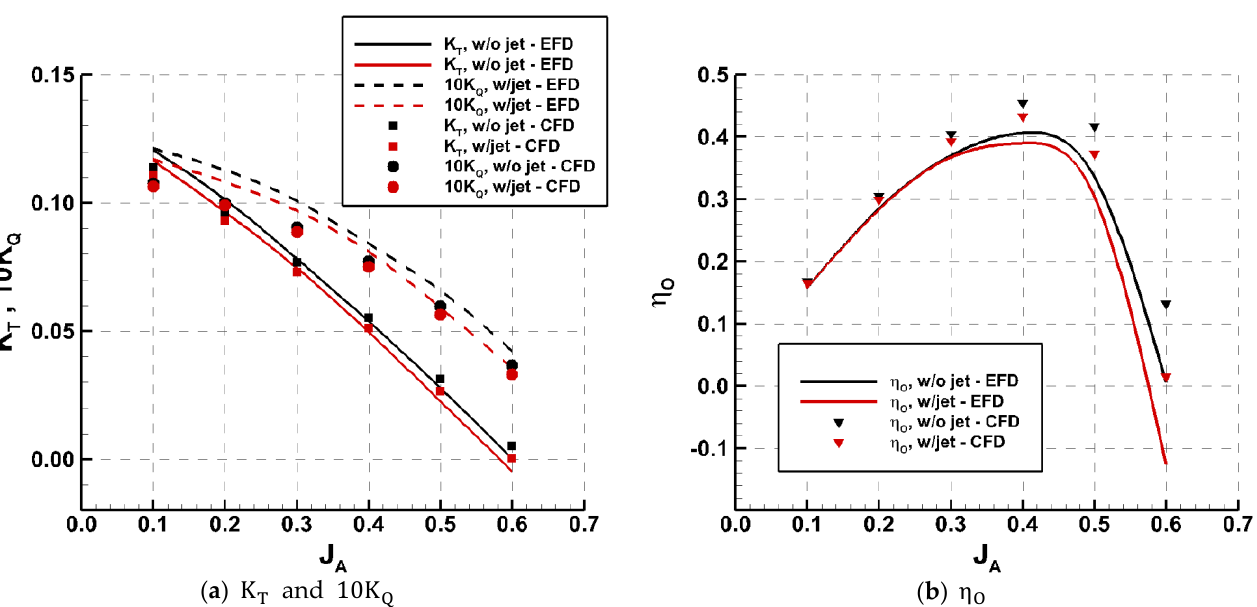
Figure 7. Propeller water test results of experiments and calculations.